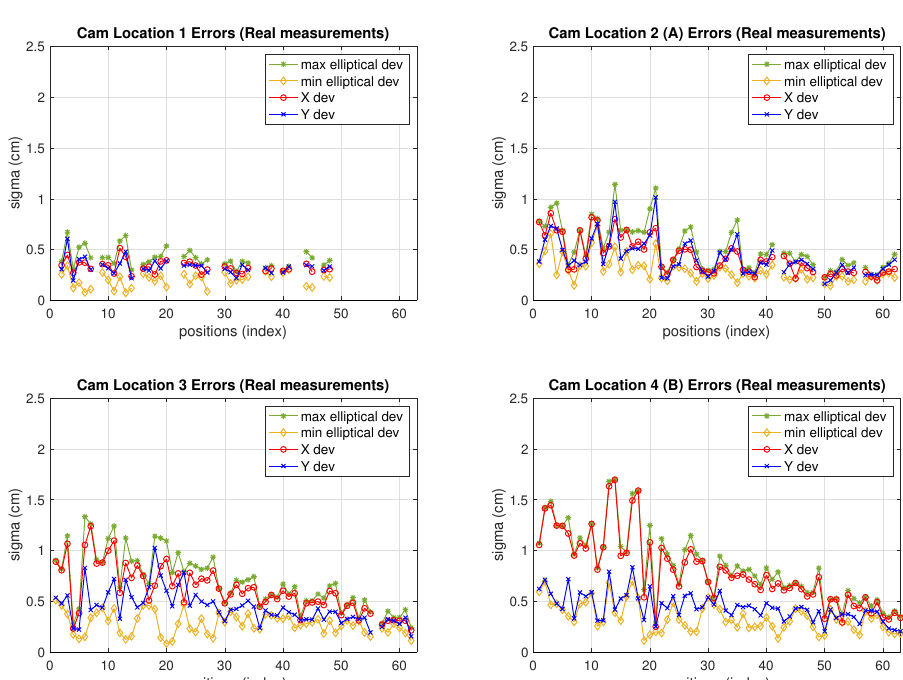
Figure 9. Test-grid and camera estimations view.